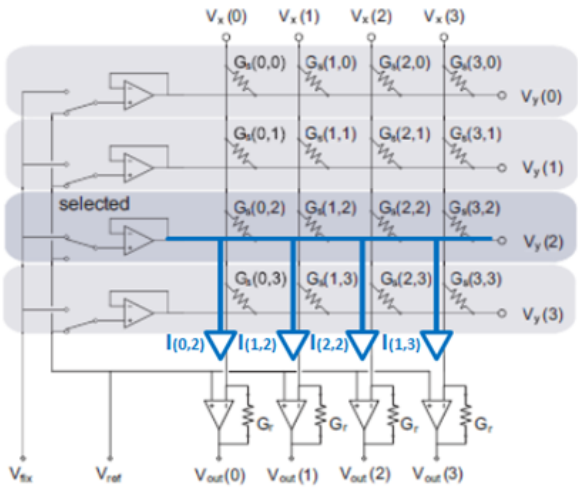
Figure 6. Anti-cross-talking signal conditioning electronic